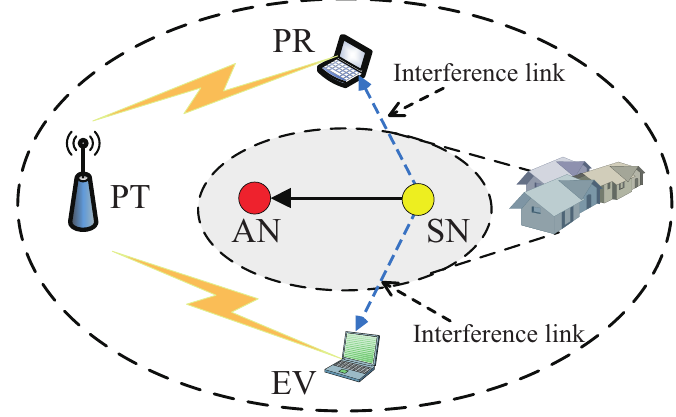
Figure 1. The system model of the proposed